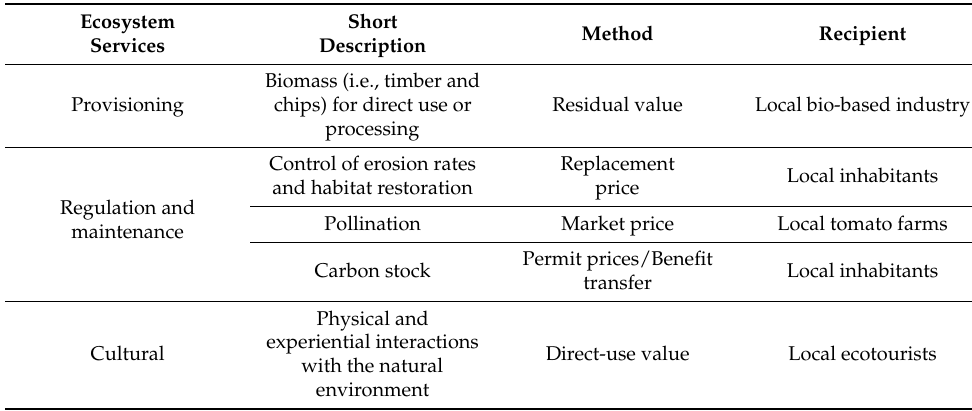
Table 1. Overview of different valuation methods and social beneficiaries used in the study for each ecosystem service, described according to Haines-Young and Potschin